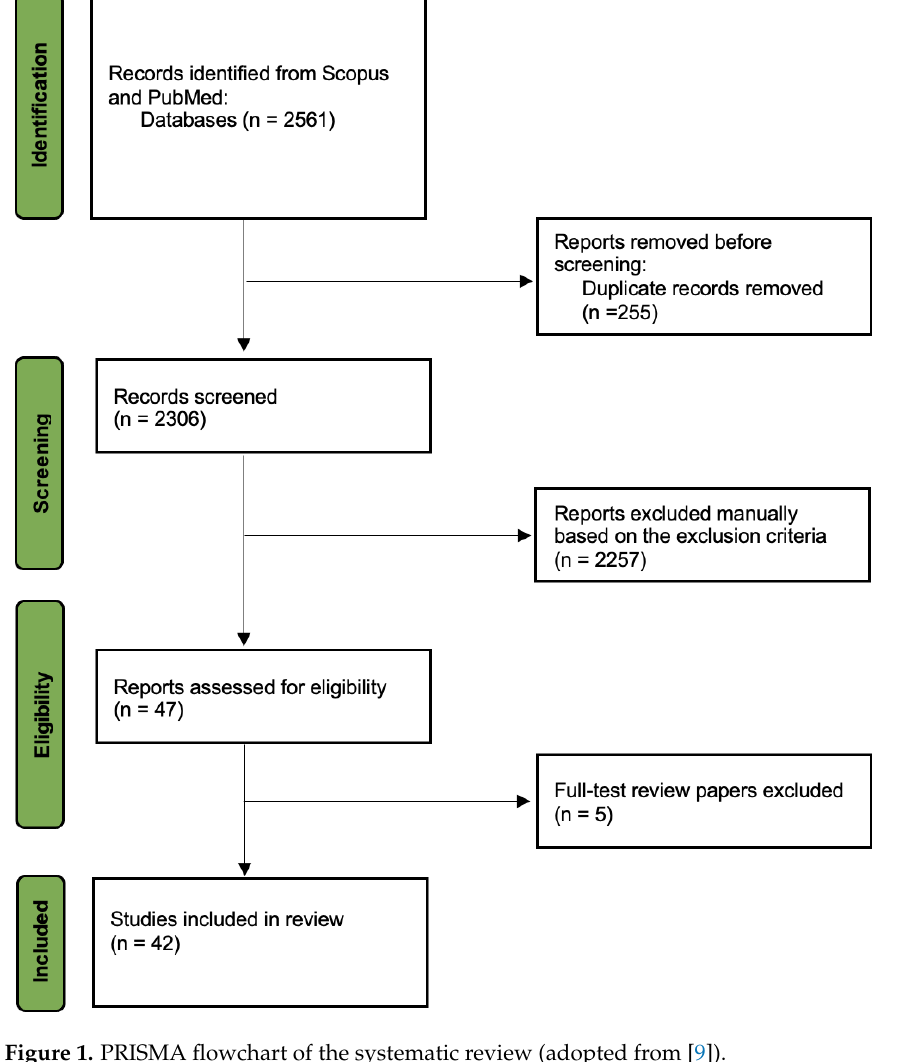
Figure 1. PRISMA flowchart of the systematic review (adopted from [9]).